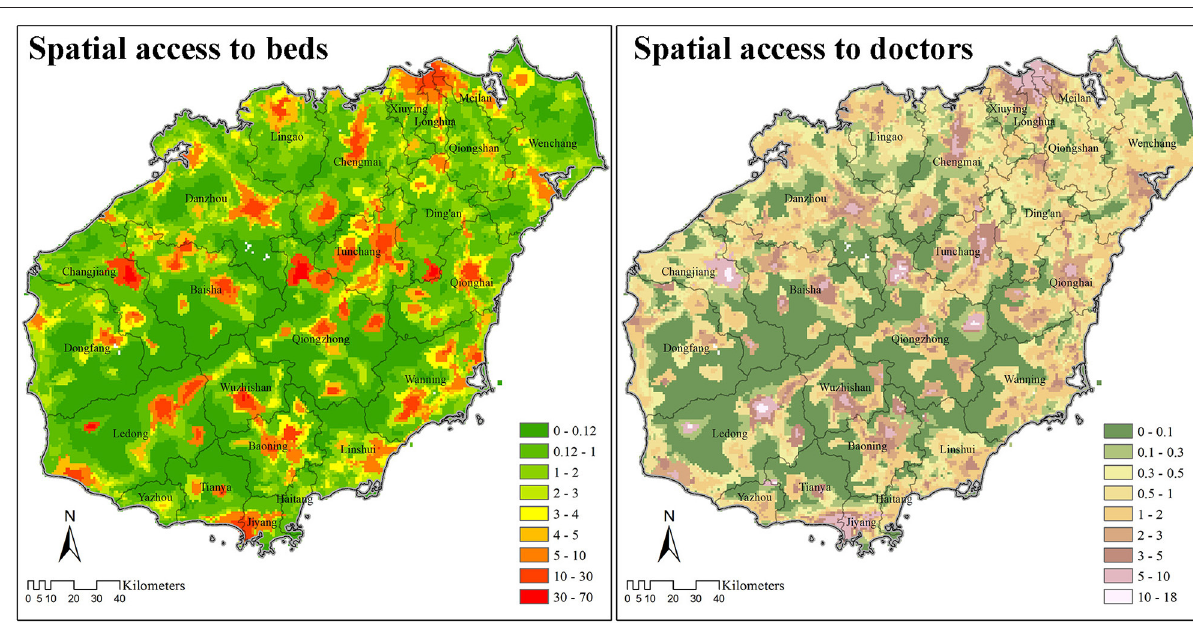
administrative units (55), or healthcare institutions, because the invested resources and the outputs are easy to obtain (56,